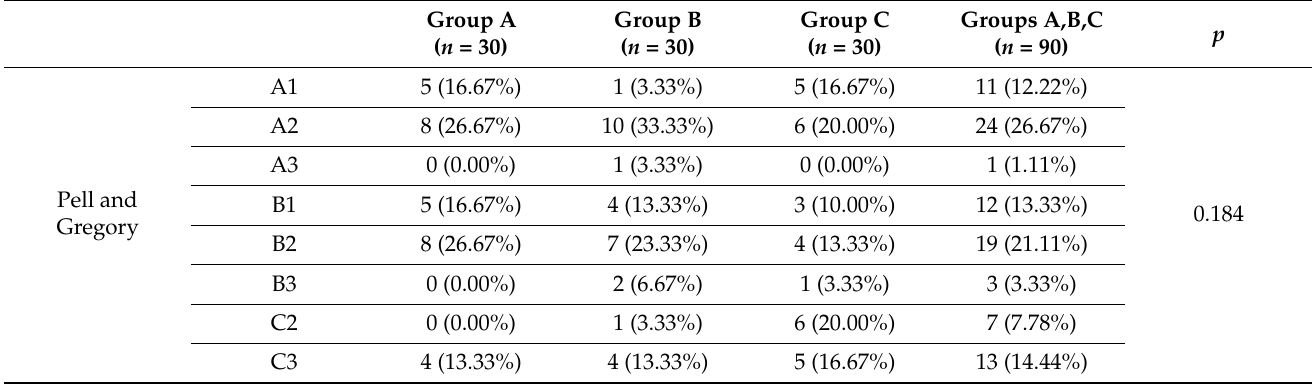
Table 1. Results of comparative analysis of the frequency of each retention class according to Pell and Gregory classification in groups A, B, C.